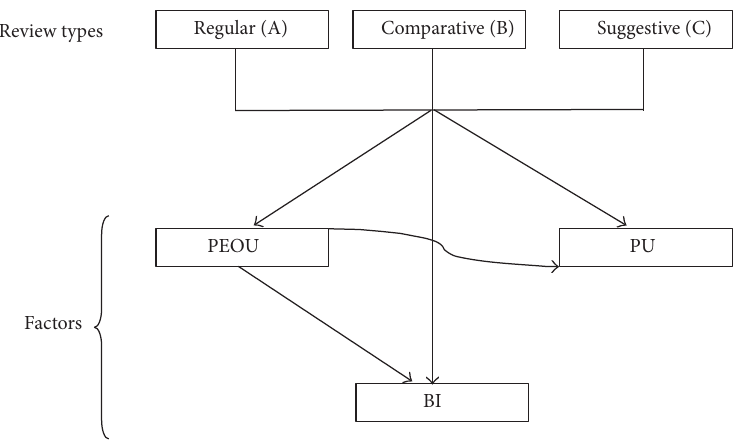
Figure 1: The proposed